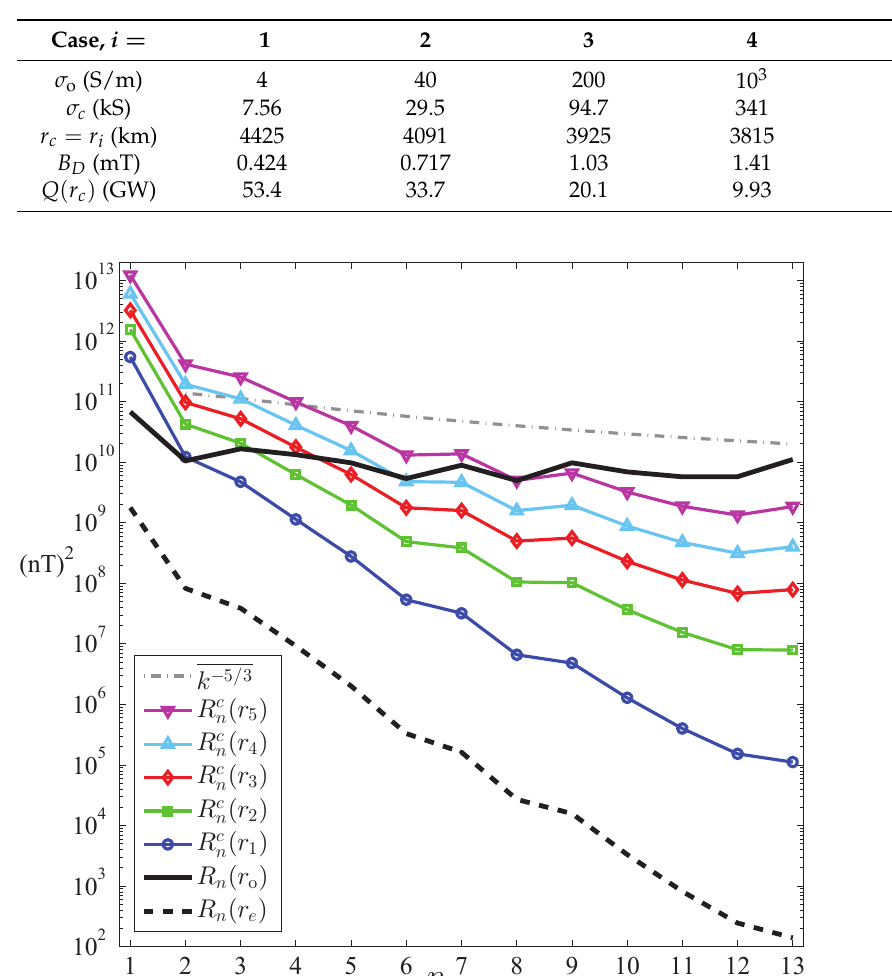
Figure 1. The modified CMB magnetic spectrum R o n ( r c ) , for r c = r i , i = 1, . . . ,5; here, in kilometers, r 1 = 4424.8, r 2 = 4090.7, r 3 = 3924.5, r 4 = 3814.7, and r 5 = 3720.8; the geometric mean is √ r m = r e r o = 4708.7. For comparison, the Mauersberger–Lowes spectra R n ( r ) at the surface r e = 6371.2 km, and CMB, r o = 3480 km; a Kolmogorov spectrum k − 5/3 is also